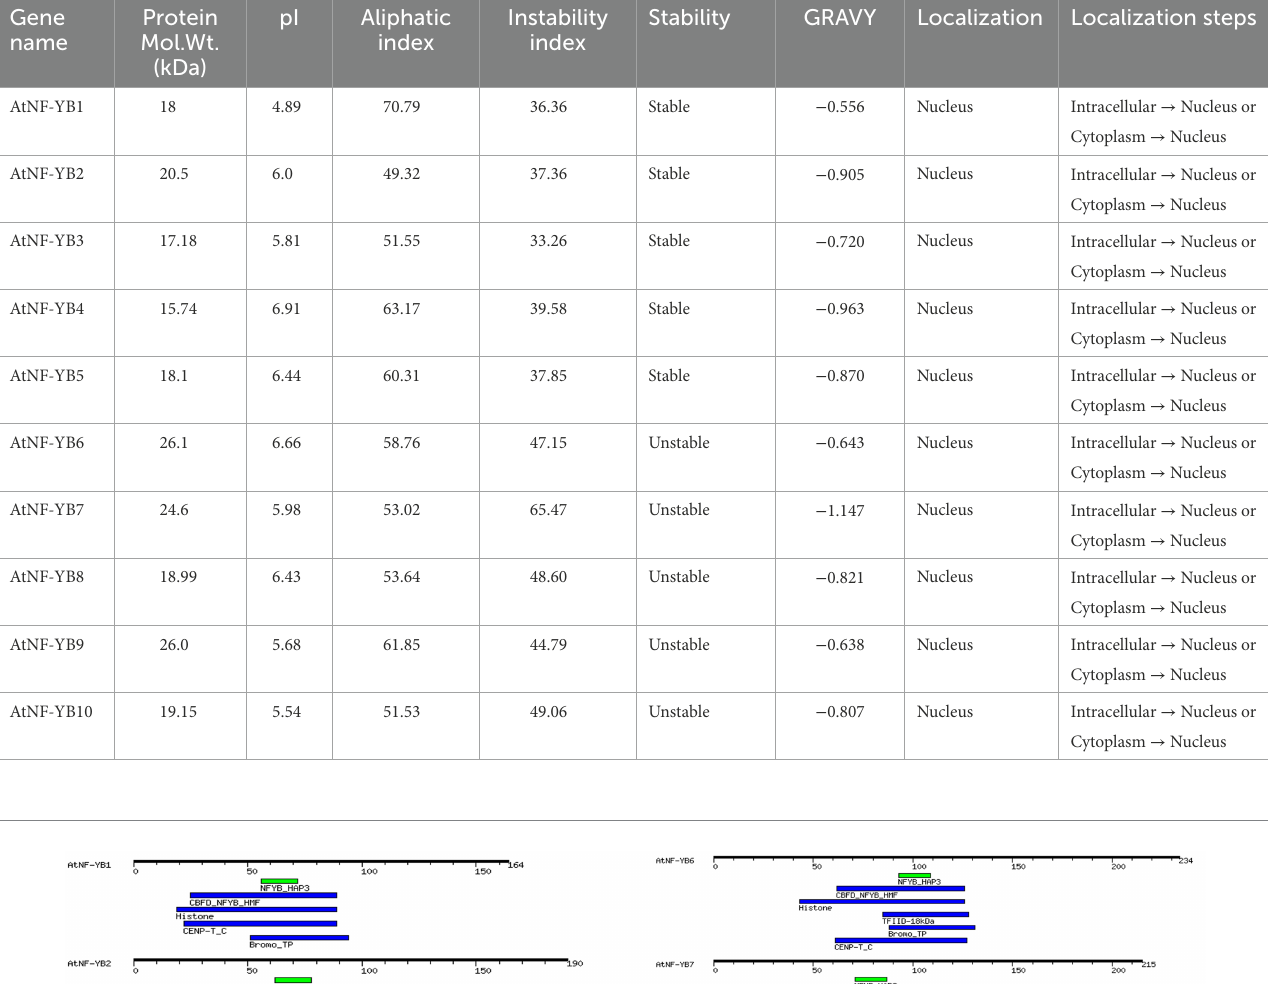
TABLE 2 Basic properties of AtNF-YB1-B10: physicochemical attributes calculated using the ProtParam